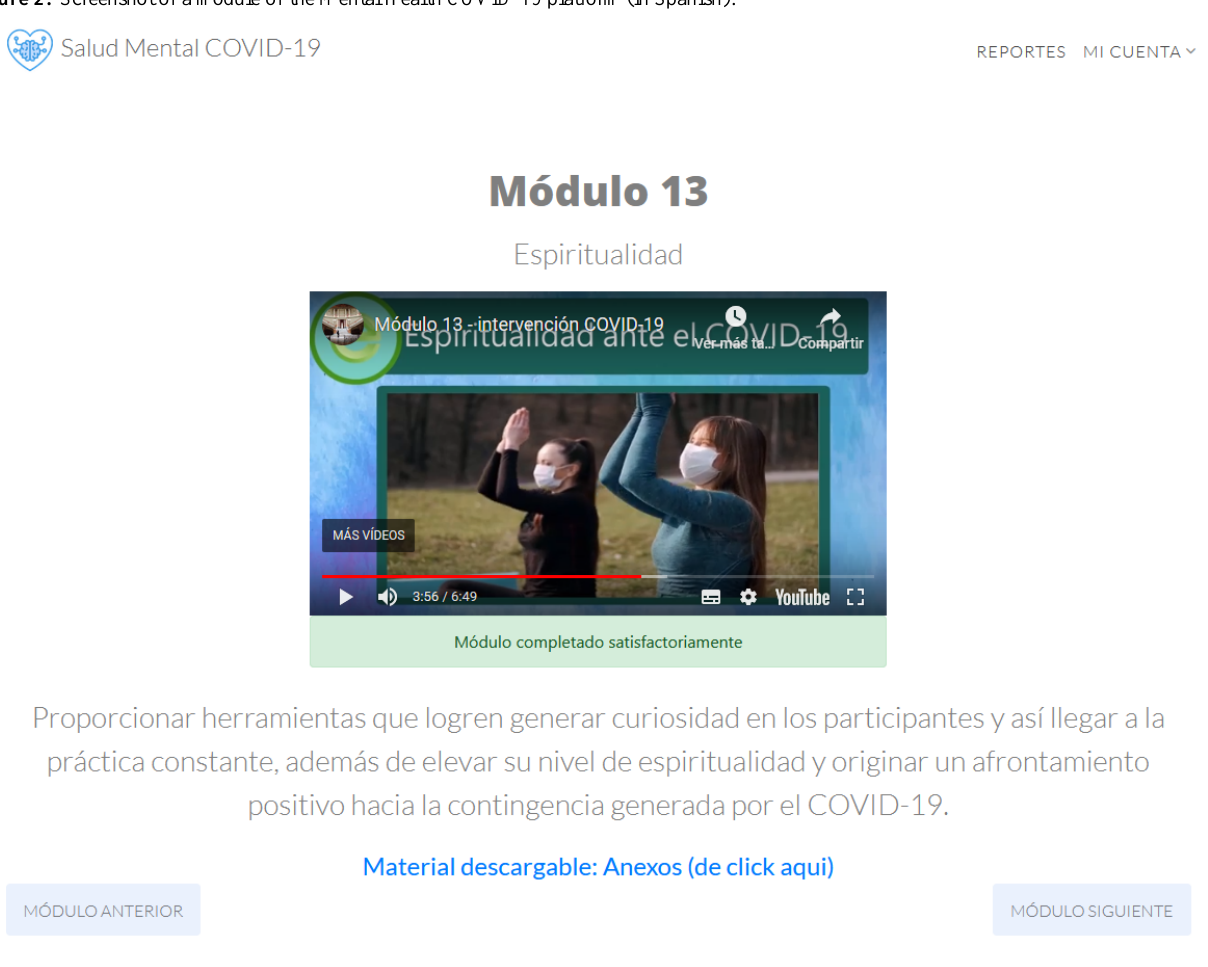
Figure 2. Screenshot of a module of the Mental Health COVID-19 platform (in